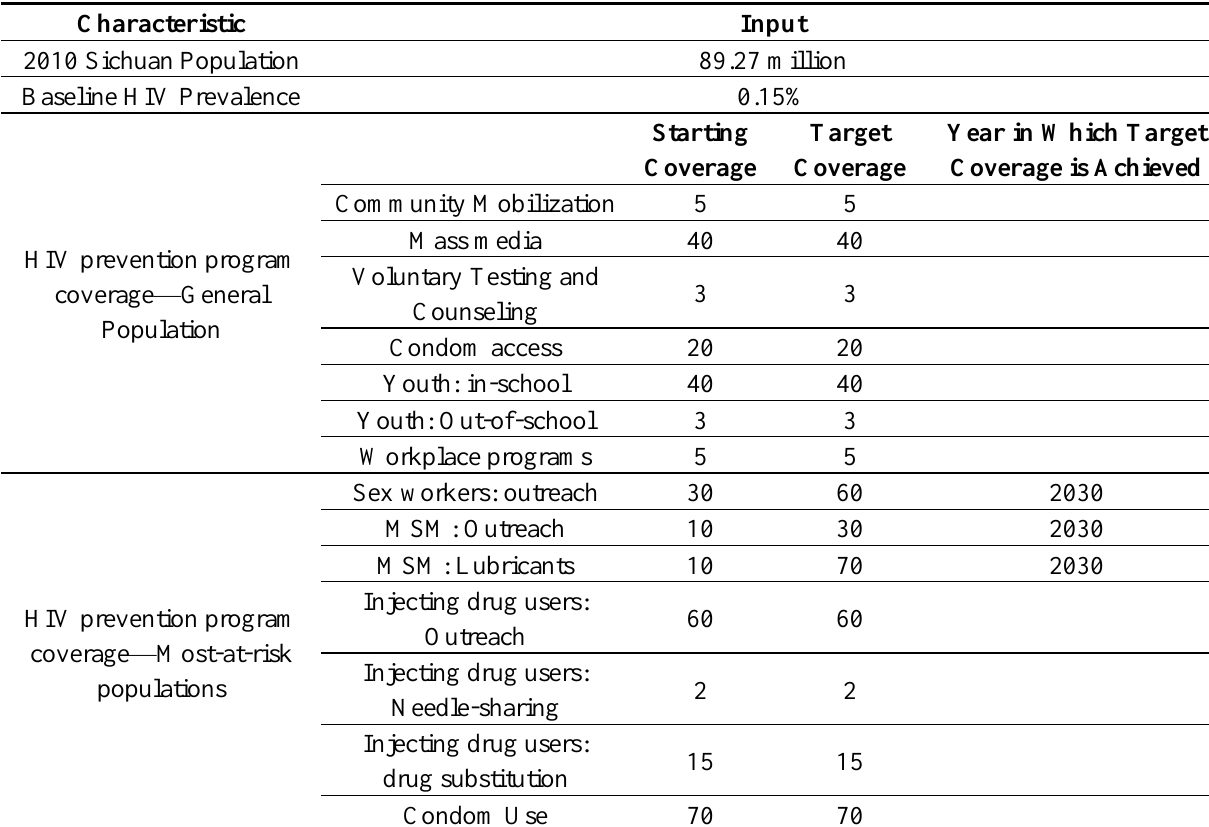
Table 1. Key model